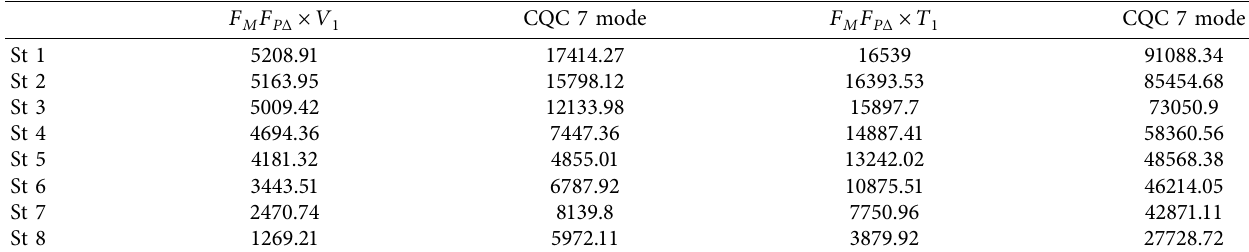
Table 13: All storeys total shear demands (kN) and torsional demands (kN · m).